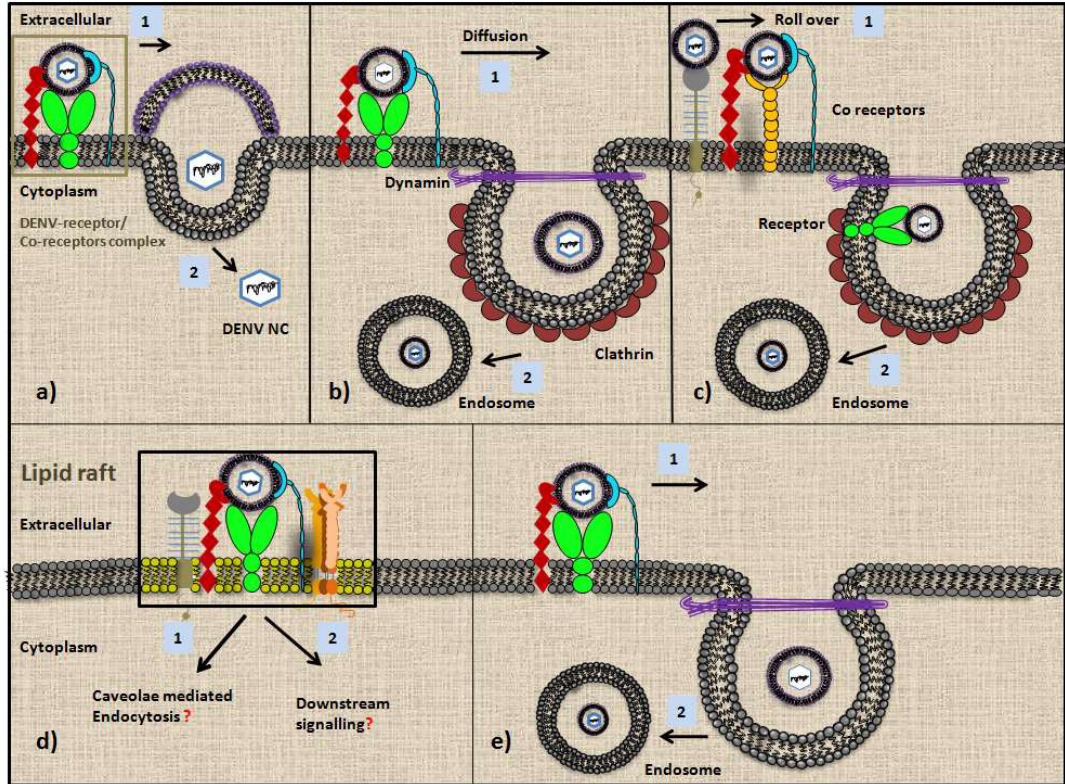
Figure 1. An overview of the different routes of dengue virus (DENV) entrance in susceptible cells via multiple receptors/co-receptors: ( a ) Direct entry of DENV in cells. a1) DENV first forms a complex with receptors/co-receptors and then a2) fuse with the cell membrane releasing the nucleocapsid (DENV NC) in the cytoplasm. ( b ), ( c ) Receptor-mediated endocytosis of DENV in cells in which b1) DENV after interacting with receptors and co-receptors diffuse along the membrane and enter through preformed clathrin-coated pit further leading to the b2) endosome formation or c1) DENV might possibly interact with co-receptors by rolling over the cell surface until it reaches to the main receptor present near or within the preformed clathrin-coated pit after which it gets c2) endocytosed. ( d ) Lipid rafts may also play an important role in DENV tropism by providing the platform for DENV interaction with multiple receptors and co-receptors, which in turn may lead to d1) caveolae-mediated endocytosis or d2) downstream signaling to enhance the receptor expression at the cell surface. ( e ) Non-classical, dynamin-dependent but clathrin-independent endocytosis is another route of entry that DENV might follow for ingress in cells.